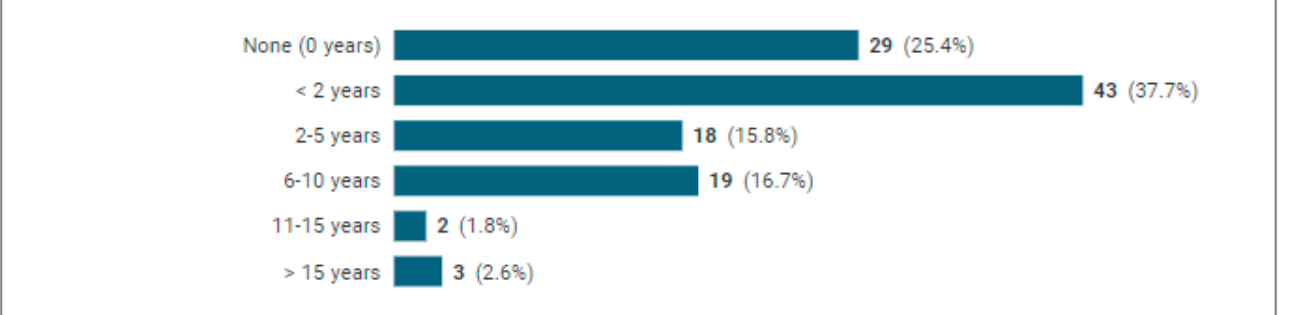
Figure 2. Years of implementing BIM and GIS in an integrated way.